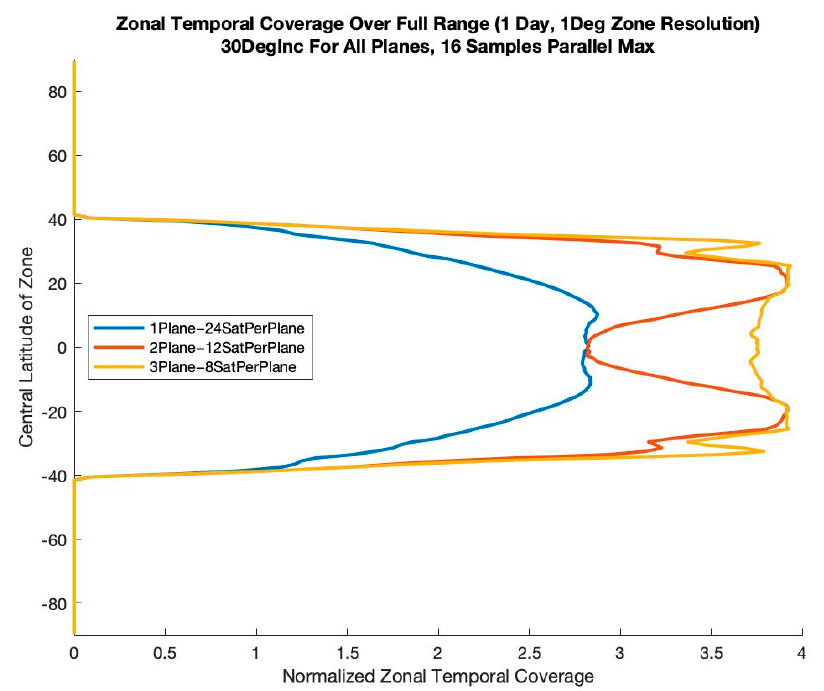
Figure 6. 24 h Temporal Coverage measurements at different latitudes for 24-satellite constellations at 800 km, 30° inclination, 16 parallel measurements per sampling, and operating with an RCG Threshold of 15. Increasing the number of constellation planes while keeping the total number of satellites constant will increase the constellation’s Zonal and Global Temporal Coverage.